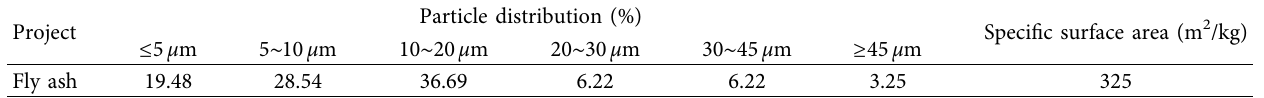
Table 7: Fly ash particle size distribution.